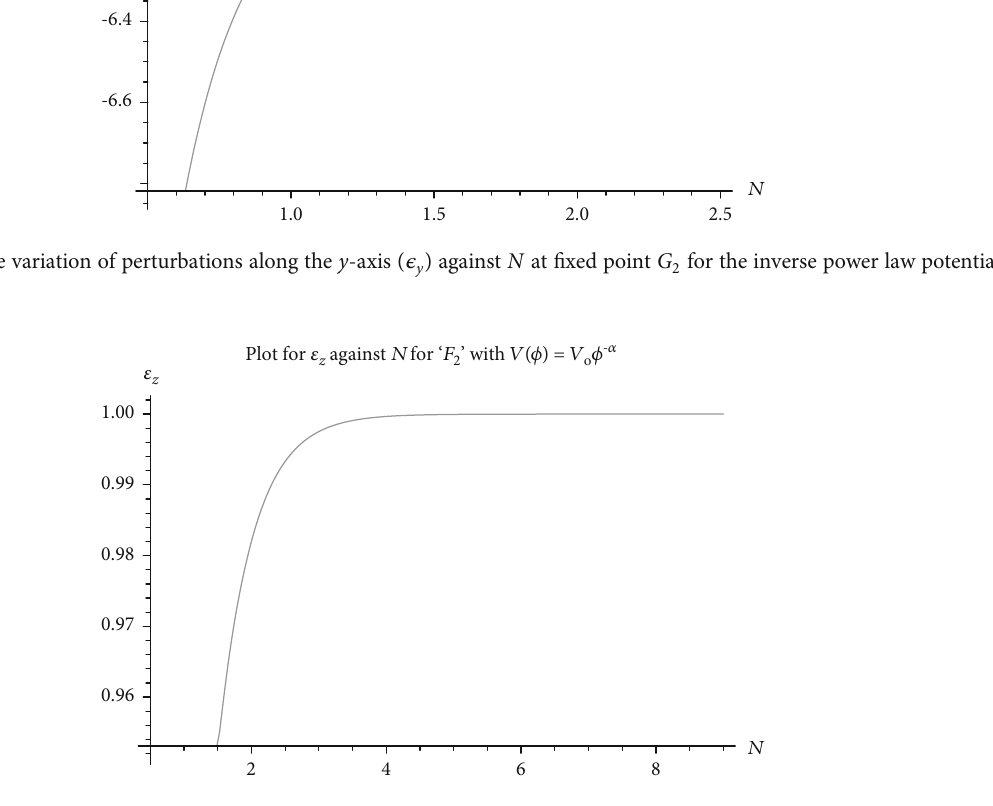
) against N at fi xed point G 2 for the inverse power law potential z